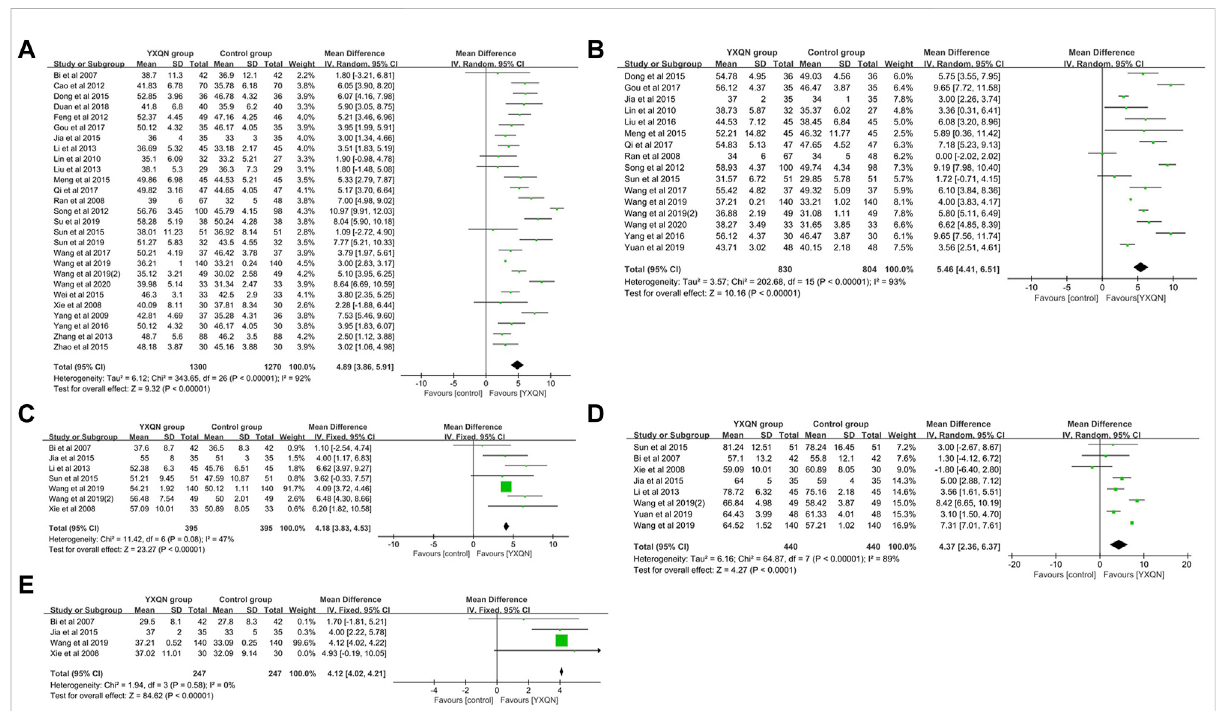
FIGURE 5 Meta-analysisofYXQNWon (A) blood fl owregulationofthebasilarartery; (B) vertebralartery ’ sblood fl owvelocity; (C) anteriorcerebralartery ’ s blood fl ow velocity; (D) middle cerebral artery ’ s blood fl ow velocity; and (E) posterior cerebral artery blood fl ow